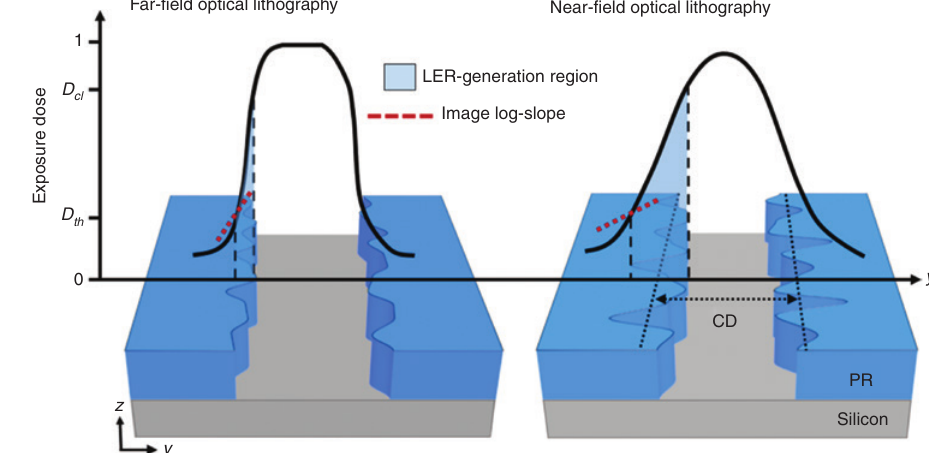
Figure 2: Schematic diagram showing the difference in LER generation in far- and near-field optical lithography. The generated pattern profile depends on the threshold dose D and the clearing dose D , which are defined as the minimum exposure th cl doses for PR removal and the clearing doses for complete PR removal, respectively. The blue areas represent the LER generation regions. Its most significant contributor is the ILS, shown as red dotted lines. ILS is defined as the quantified profile steepness at the line edge position (i.e. the position of the full width at tenth maximum (FWTM) of the generated line profile). Note that the evanescent field can induce small ILS and thereby lead to a larger LER in